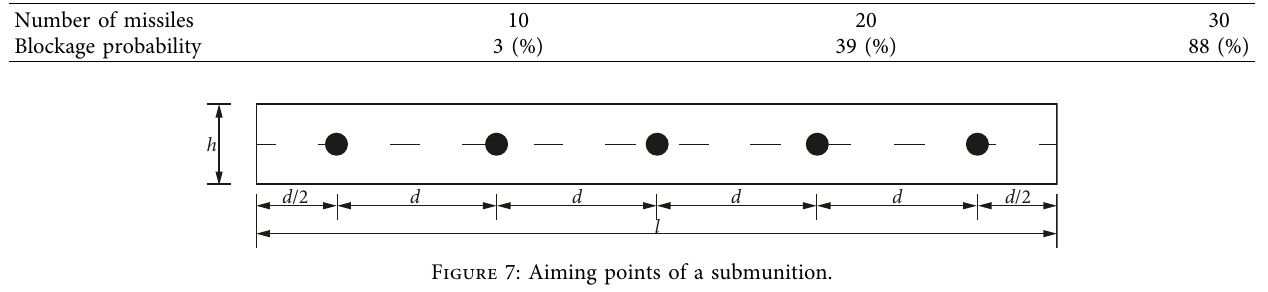
Figure 7: Aiming points of a submunition.